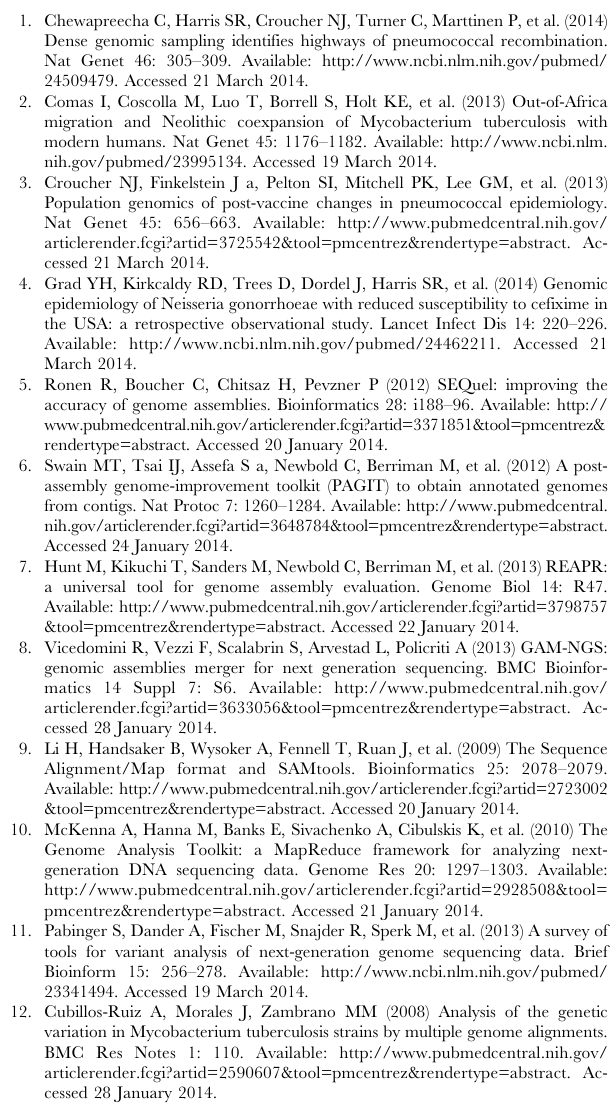
Table S8 Curation of Mtb F11. Table S9 Pilon Command Line